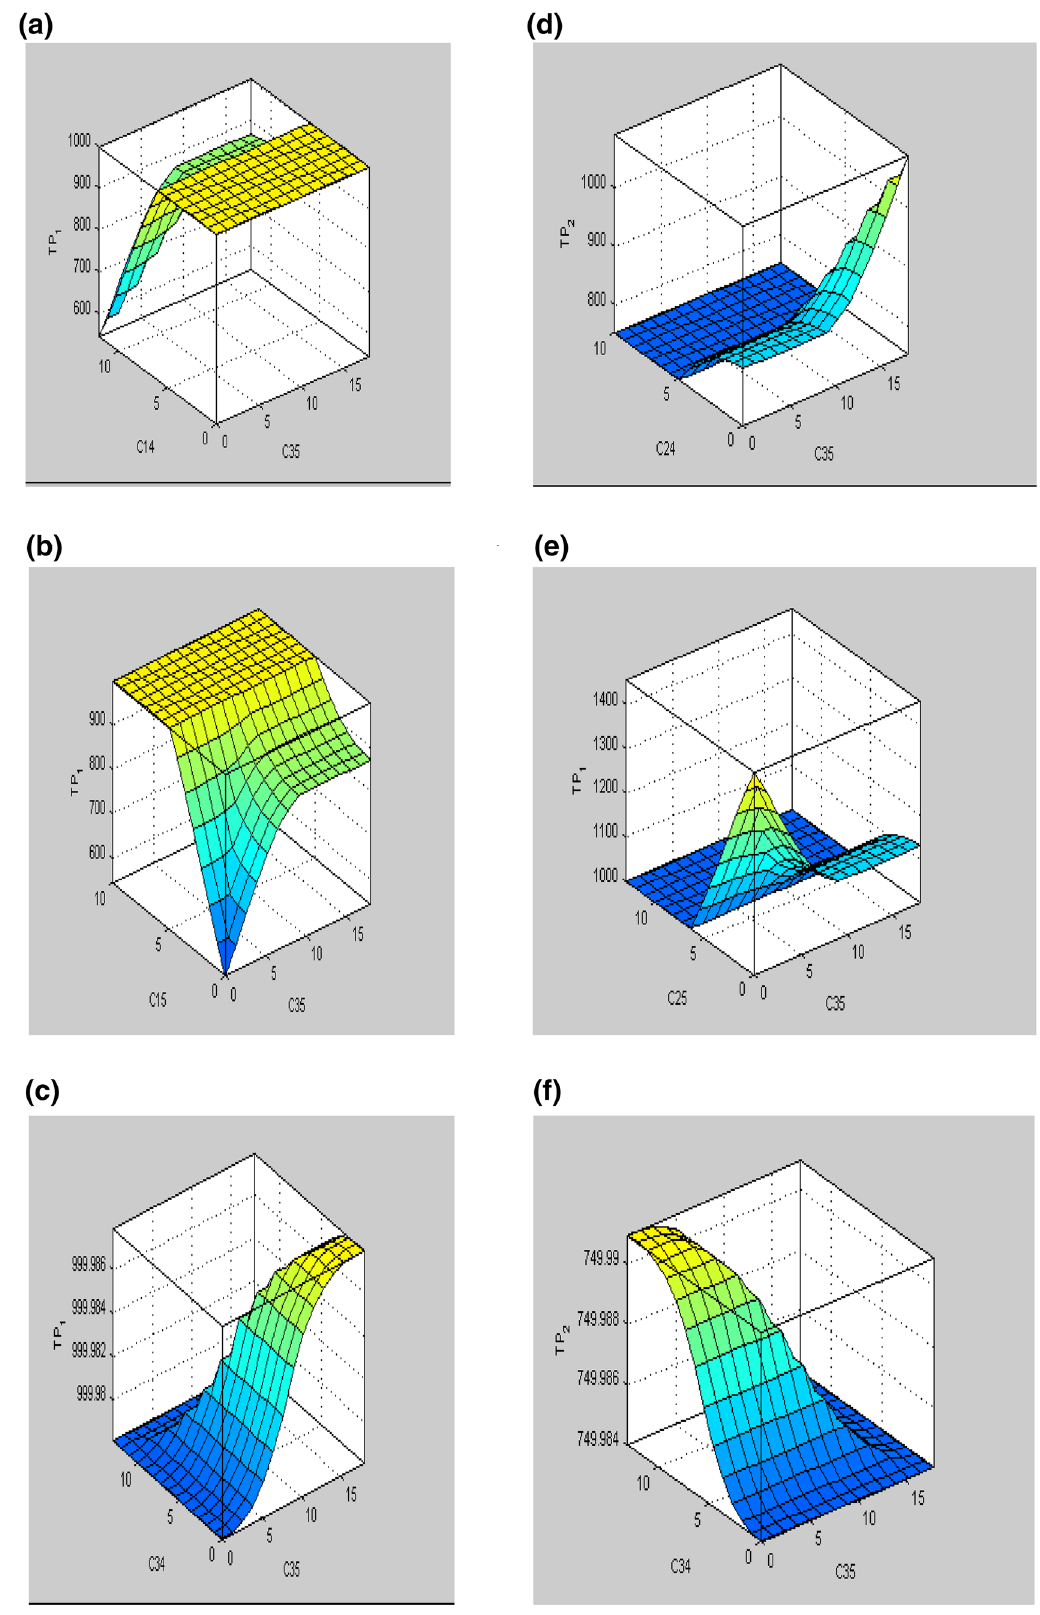
Fig. 5 3D input–output control surface plot fuzzy inference system ( a – f